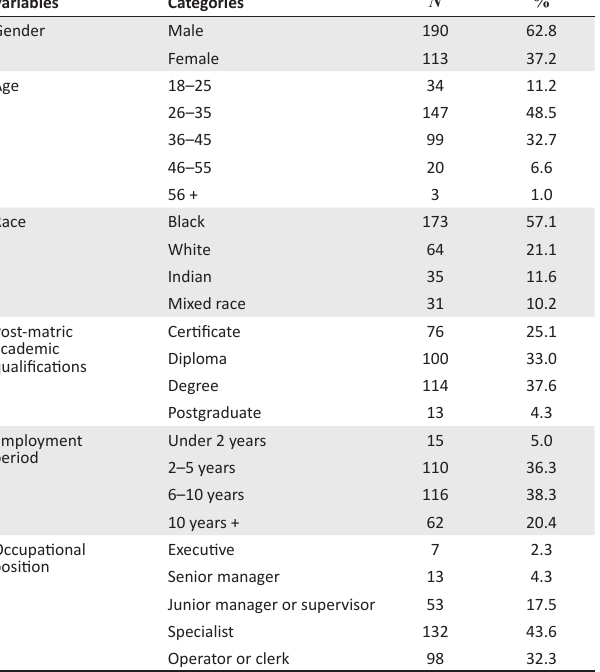
TABLE 4: Demographic details of